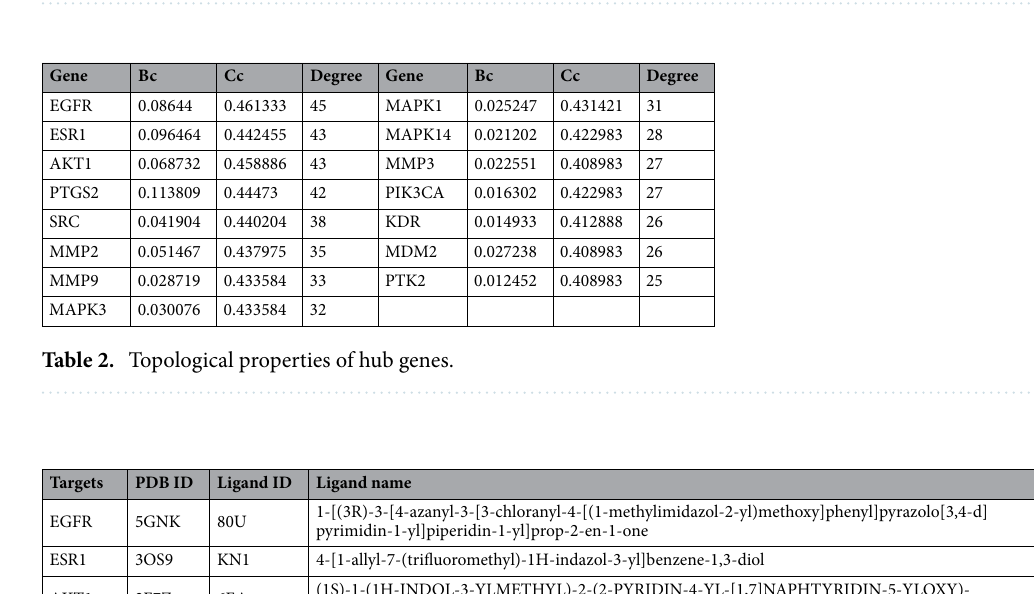
Table 1. Topological properties of hub components in fifteen degree.